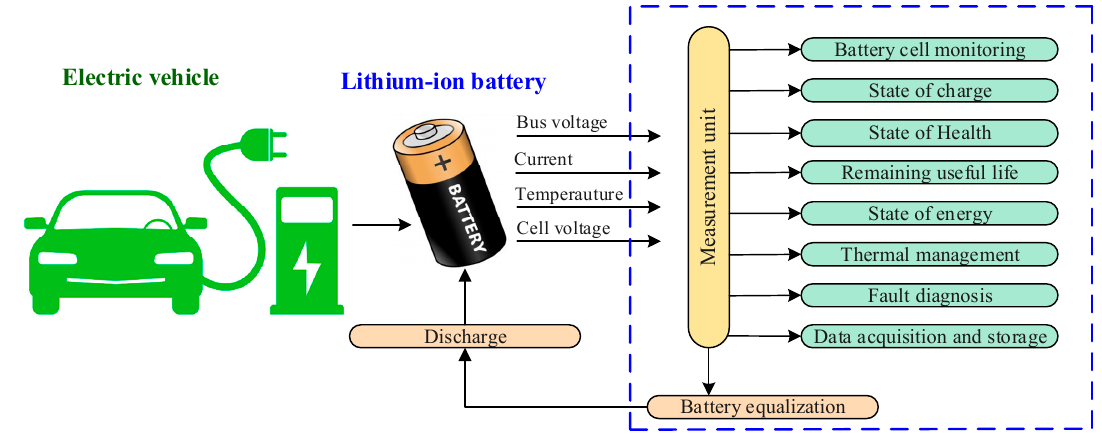
Figure 2. Various critical applications of BMS in EV